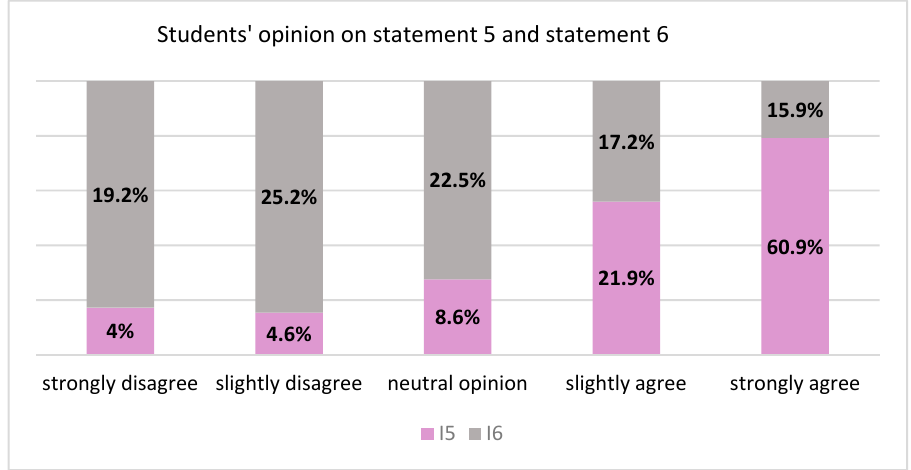
Figure 1. Opinion on statement 5 vs. statement 6.